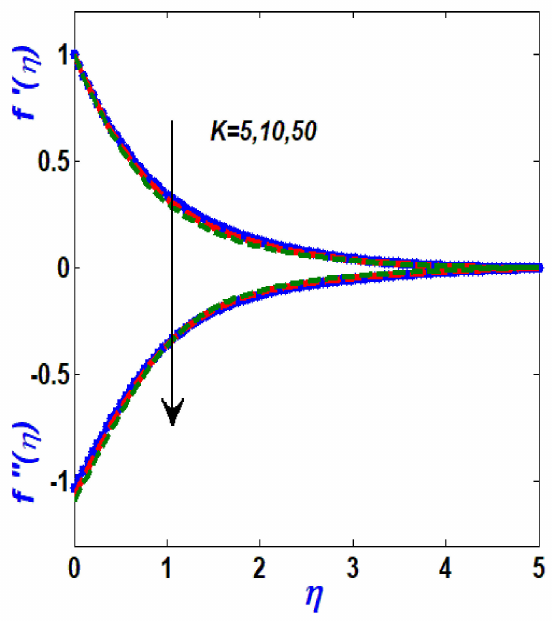
Figure 1. Velocity & acceleration profiles with variation in K